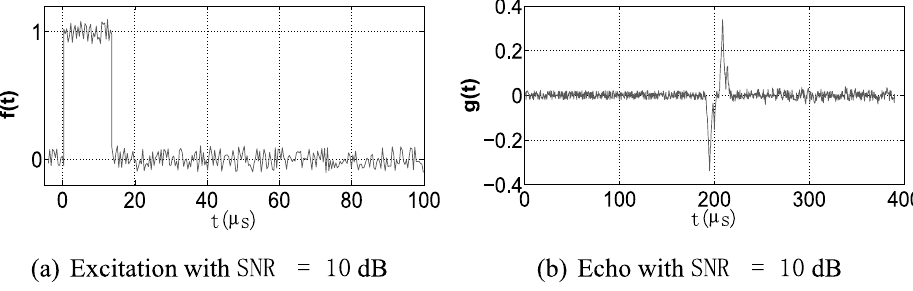
Fig. 22. Long rectangular incident pulse and corresponding echo, SNR = 10 dB.